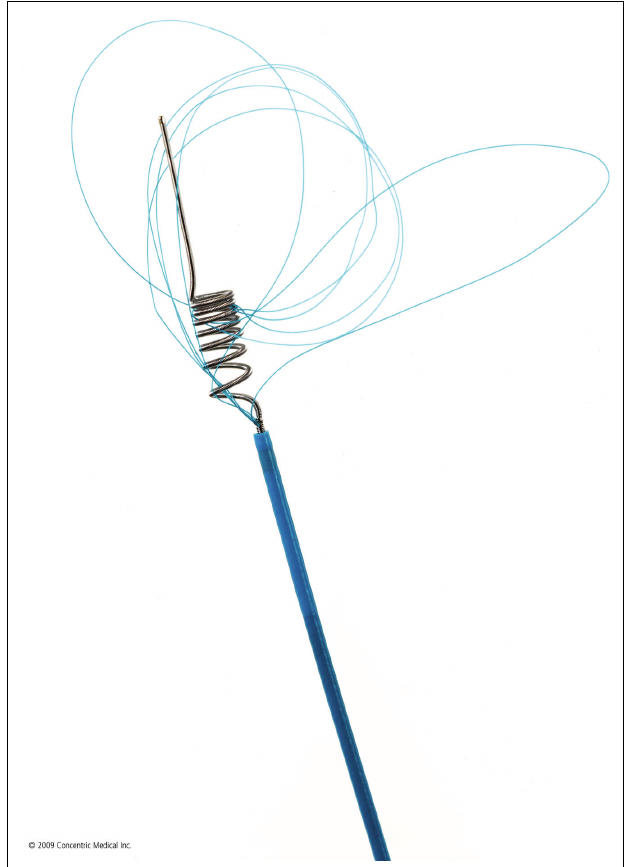
FIGURE 1 | Merci RetrieverV 2.5 series (with permission, Concentrics Medical)